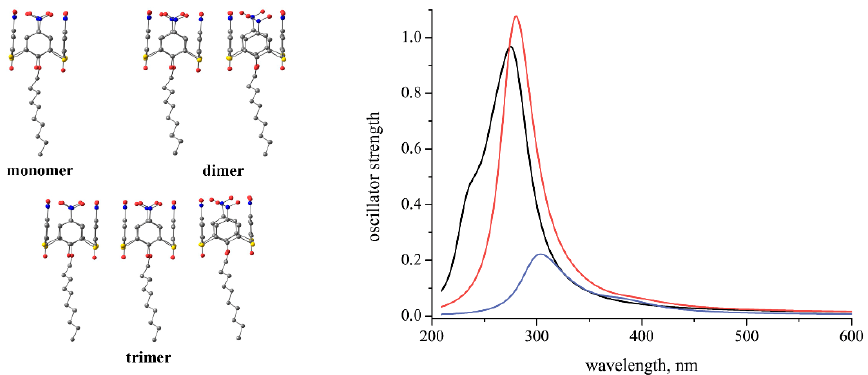
Figure 13. Quantum chemically calculated UV spectra of non-optimized monomer (black), dimer (red), and trimer (blue) models.